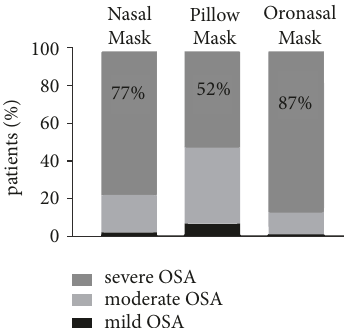
Figure 3: Type of interface selected according to AHI-based OSA